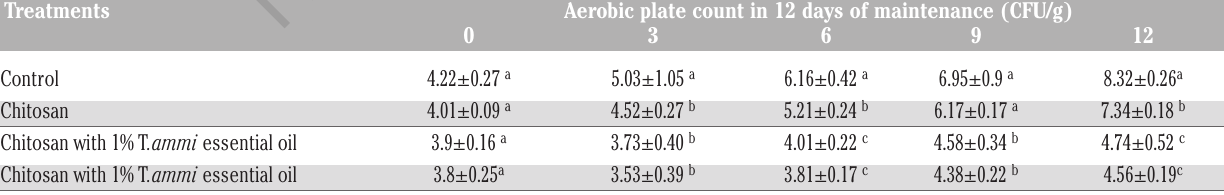
Table 1. Levels of aerobic plate count for various treatments of chicken fillet on maintenance period. Treatments